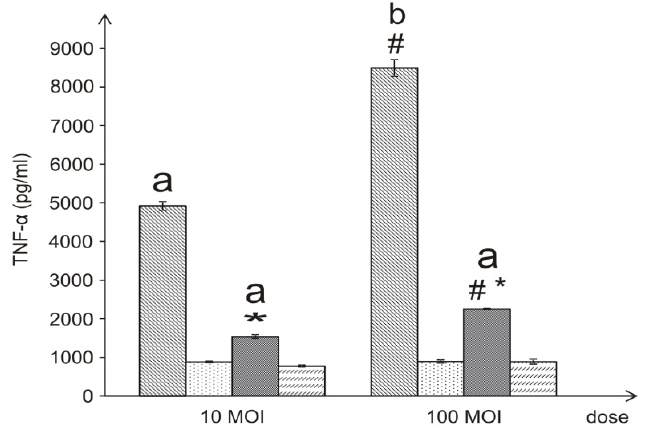
Figure 8. Effects of live and temperature-treated L. dumoffii cells cultured on the choline-supplemented medium and without choline on the ability to induce TNF- α production in THP-1 differentiated cells. Data represent the mean ± S.D. of five independent experiments. Control THP-1 differentiated cells (PMA-activated): TNF- α 22.6 ± 0.6 (pg/mL); Control non-activated THP-1 cells: TNF- α 18.32 ± 0.9 (pg/mL). # Significantly different from the lower bacteria dose, p ≤ 0.05; * Statistically significant in comparison to bacteria cultured on the choline non-supplemented medium, p ≤ 0.05 (ANOVA and Tukey’s post hoc test). a,b Statistically significant in comparison with similar experiments preformed